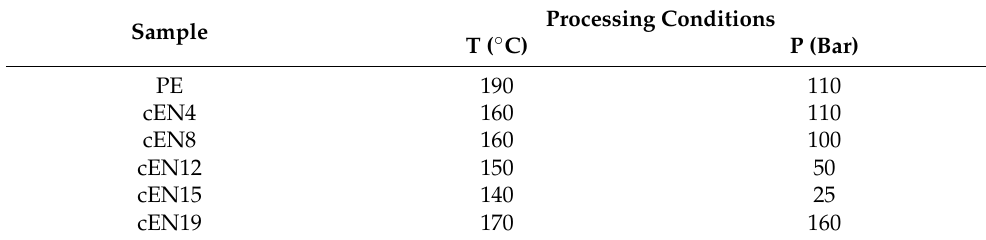
Table 2. Conditions used for the processing of